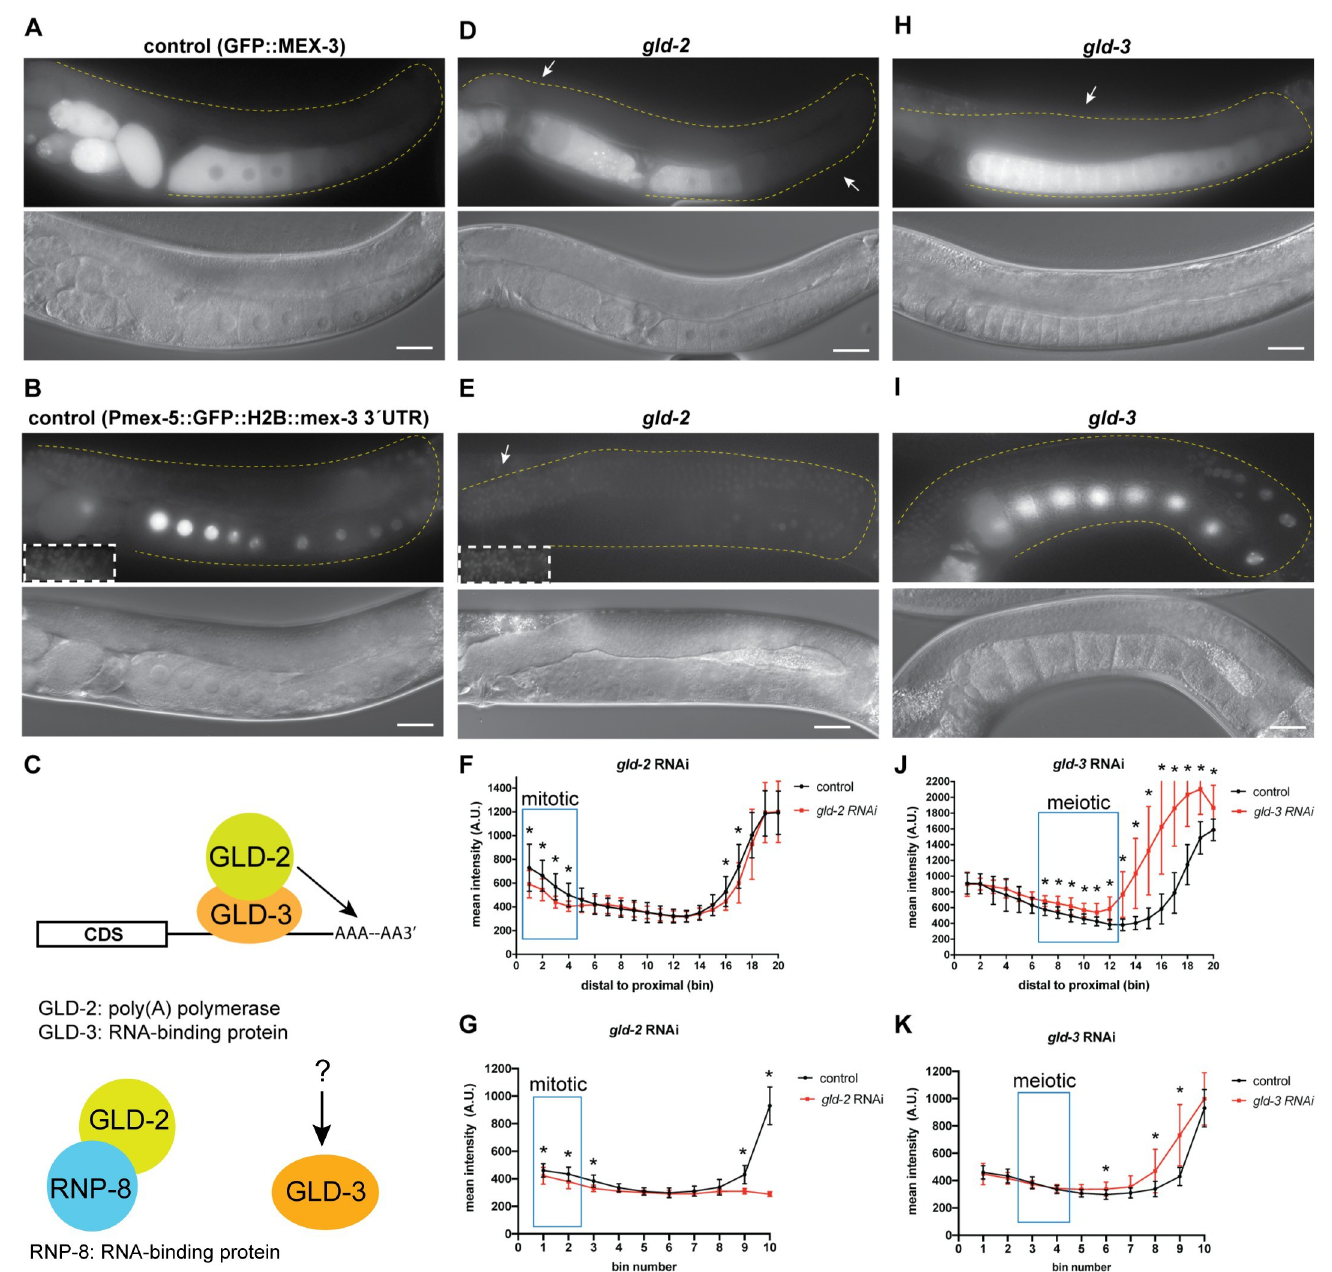
Fig 6. Polyadenylation contributes to regulation of MEX-3 in the germline. (A) DIC and fluorescence images of wild type GFP::MEX-3 animals from the control RNAi. (B) DIC and fluorescence images of the gfp :: mex-3 3 ´ UTR transgenic reporter strain from the control RNAi. (C) a model representing the known mechanism of GLD-2 and GLD-3 mediated polyadenylation. GLD-2, which lacks an RNA-binding domain, is thought to utilize the RBPs GLD-3 or RNP-8 in order to bind its target mRNAs. GLD-3 also exhibits functions independent of its role with GLD-2. (D) DIC and fluorescence images after gld-2 knockdown. GFP::MEX-3 was significantly reduced in the distal mitotic end. (E) DIC and fluorescence images after gld-2 knockdown in the transgenic reporter strain. Transgene expression was significantly reduced in the distal mitotic end. (F) quantitative analysis of fluorescence intensity after gld-2 knockdown in the GFP::MEX-3 strain (n = 15/15). (G) quantitative analysis of fluorescence intensity after gld-2 knockdown in the gfp : mex-3 3 ´ UTR strain (n = 14/14). (H) DIC and fluorescence images after gld-3 knockdown in the GFP:: MEX-3 strain. GFP::MEX-3 expression was increased in the pachytene and oogenic regions. (I) DIC and fluorescence images after gld-3 knockdown in the gfp :: mex-3 3´UTR transgenic reporter strain. Transgene expression was not increased in the meiotic region but was increased in the oogenic region. (J) quantitative analysis of fluorescence intensity after gld-3 knockdown in the GFP::MEX-3 strain (n = 7/12). (K) quantitative analysis of fluorescence intensity after gld-3 knockdown in the gfp : mex-3 3 ´ UTR strain (n = 10/10). ( � ) indicates statistical significance, adjusted p-value � 0.05. All p-values for this figure are reported in S7 and S8 Tables. Scale bar = 30 μ m.